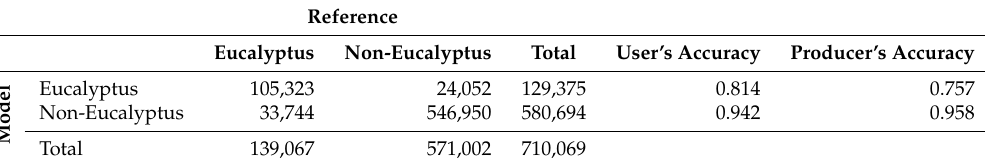
Table A1. Confusion Matrix for the model output at a threshold of 0.53 for Area (1).